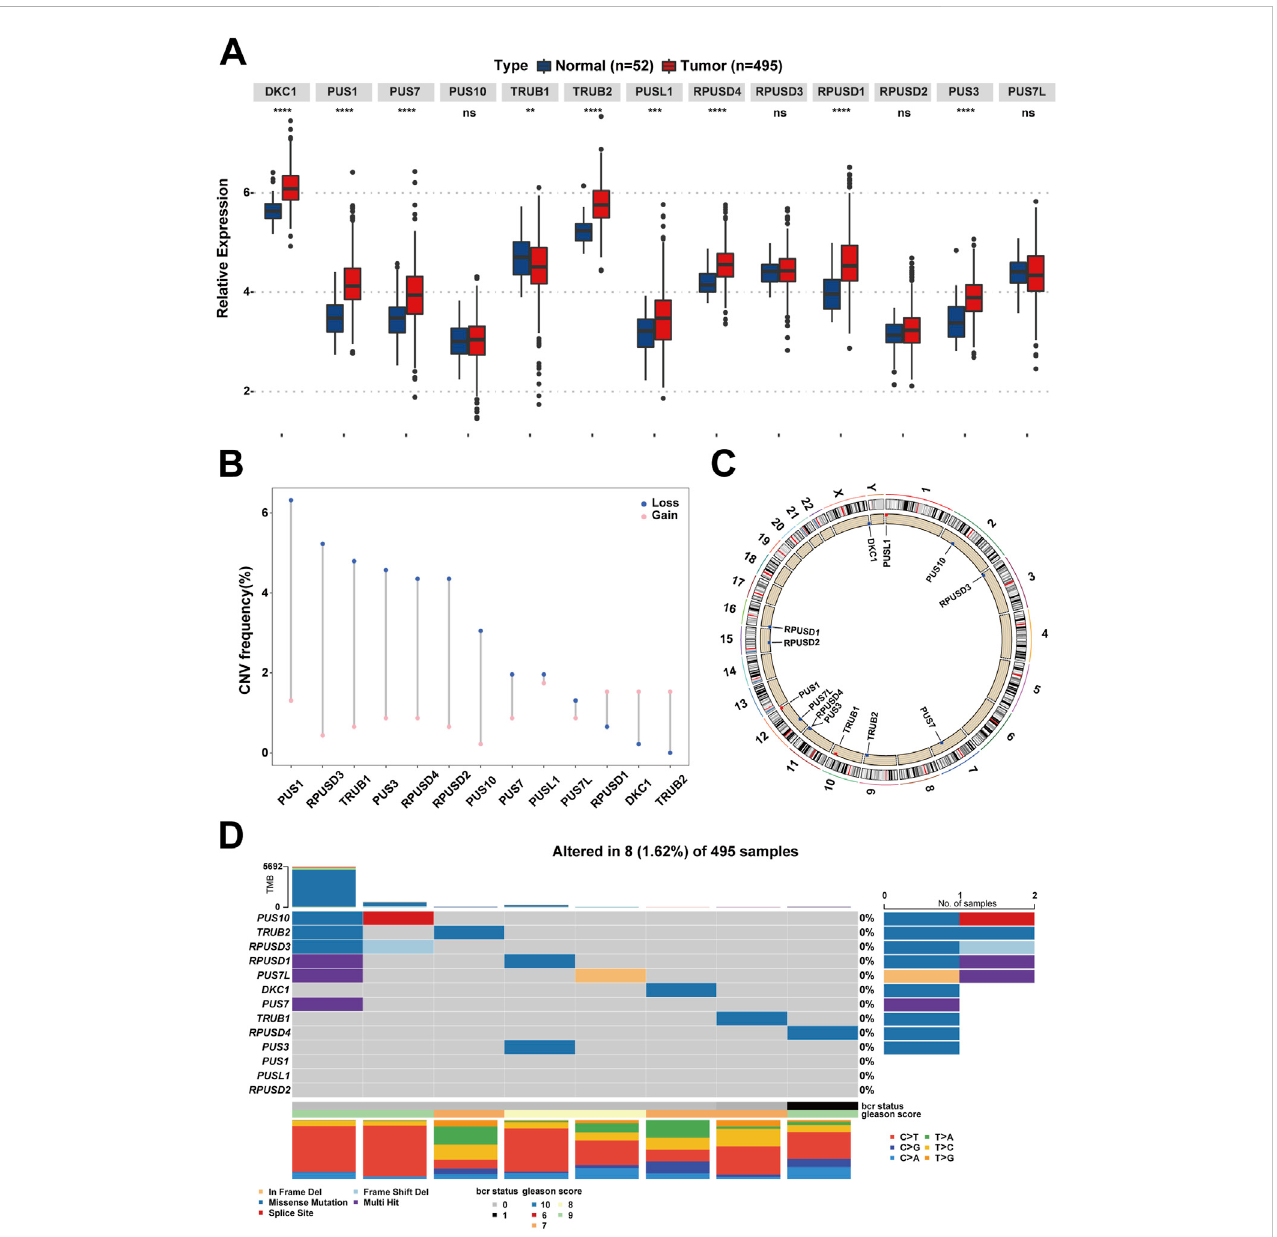
FIGURE 2 The landscape of Ψ -related regulators on expression, mutation, and chromosome location in PCa. (A) The differences of gene expression of the 13 Ψ - related regulatorsbetween tumor tissues andadjacentnormal tissues intheTCGA-PRADcohort. Ns, no signi fi cance;** p < .01; *** p < .001; **** p < .0001. (B) The CNV frequency diagram of the 13 Ψ -related regulators. The two endpoints of each column correspond to two CNV values of a speci fi c Ψ -related gene, with a blue point representing the depletion (Loss) frequency and a pink point denoting the ampli fi cation (Gain) frequency, respectively. (C) The exact mutation locations of the 13 Ψ -related regulators on chromosomes. (D) Eight of 495 (1.62%) PCa patients appeared genetic alterations in the 13 Ψ -related regulators, most of which were missense mutations. The percentages (0%) on the right indicate the mutation frequencies of each Ψ -related regulator, respectively. Each column represents an Ψ gene-mutated